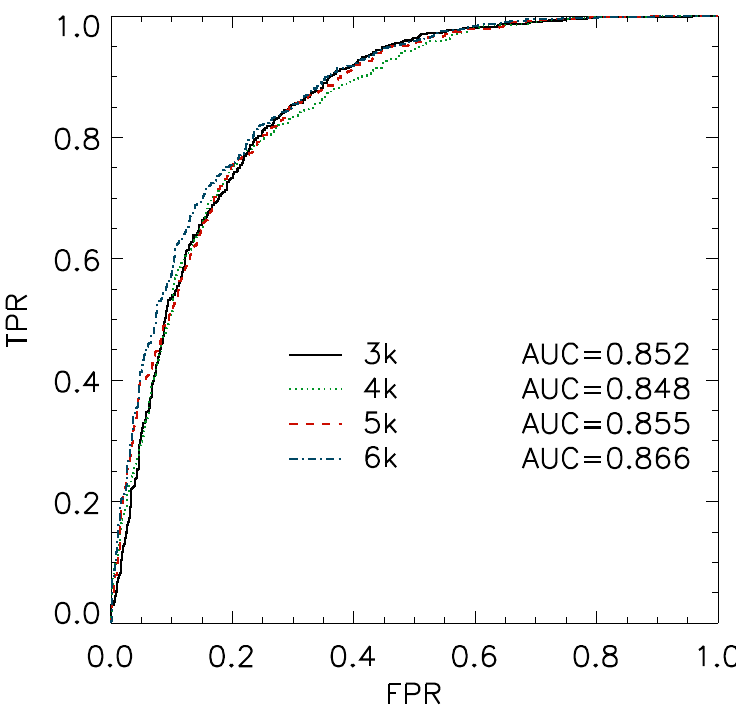
Figure 2. The ROC curves for various cluster definitions. We vary the boundary of the cluster membership in the line-of-sight velocity to check if we have any particular sensitivity to a certain physical scale. The labels marked ‘3 k’, ‘4 k’, ‘5 k’, and ‘6 k’ represent 3000, 4000, 5000, and 6000 kms − 1 velocity boundaries relative to the rest frame cluster velocity,